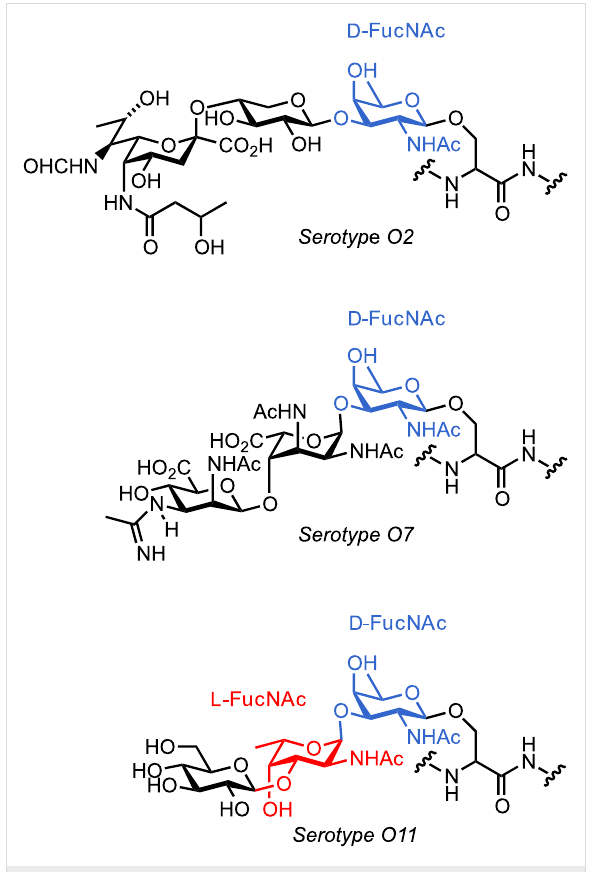
Figure 1: Structure of some O -linked glycans found on the cell surface of P. aeruginosa .